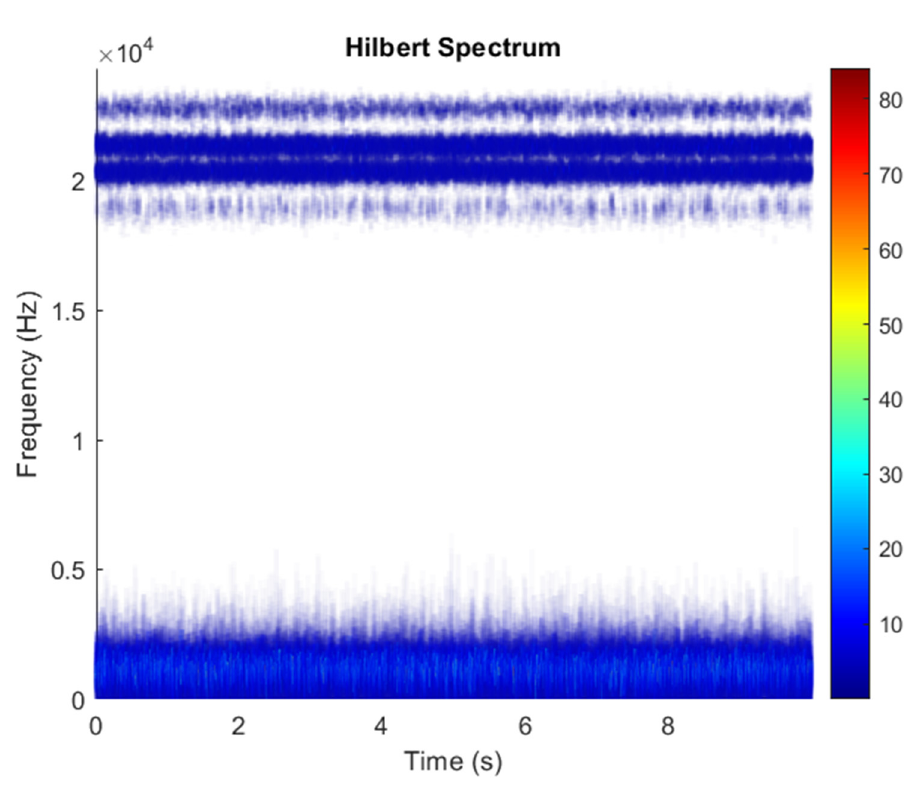
Figure 29. Analysis of data separated by VMD-ICA’s Hilbert Spectrum results.